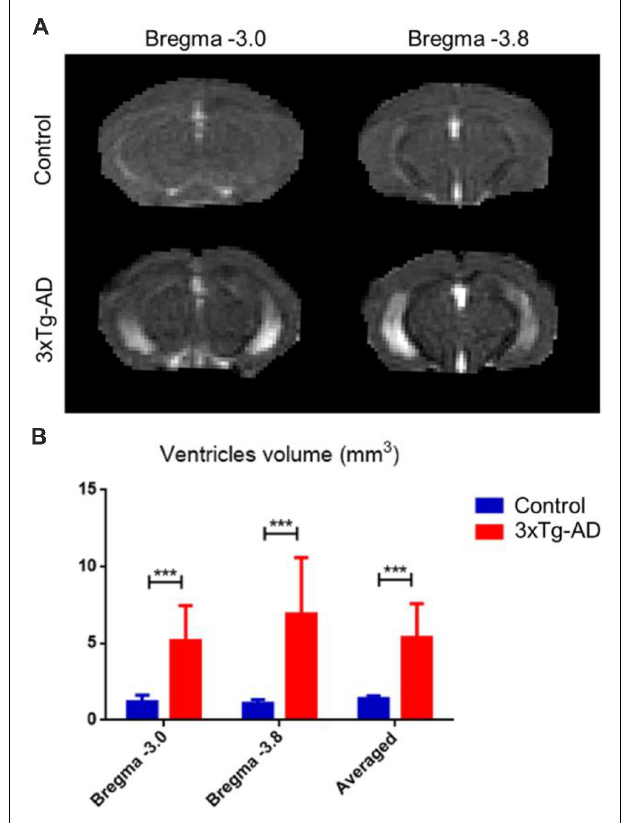
FIGURE 4 | Ventricular enlargement in 3xTg-AD compared with control mice. Using the RD λ ⊥ map of each mouse minimizes partial volume of gray matter (GM) and white matter (WM) structures. (A) The 3xTg-AD group average ventricular enlargement along Bregma − 3.0 and − 3.8. (B) Bar plot of ventricle size in mm 3 along Bregma − 3.0, and − 3.8 for 3xTg-AD (red) and control (blue). Ventricles were calculated by delineating the RD λ ⊥ map of each ventricle to minimize the partial volume of GM and WM structures. The volume (mm 3 ) of ventricles was then determined and compared. The asterisk ∗∗∗ represents highly significant P < 0.001